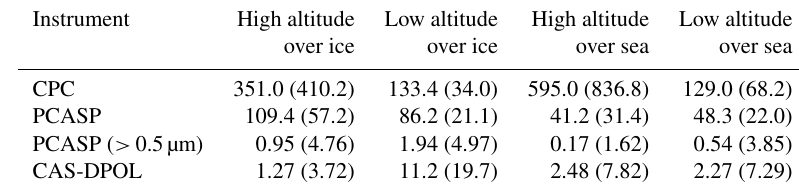
Table 5. Background aerosol information, split into high- ( > 800m) and low-altitude ( < 800m) data over the respective surfaces. Arithmetic mean values of number concentration (cm − 3 ) are reported, with 1 standard deviation in brackets.